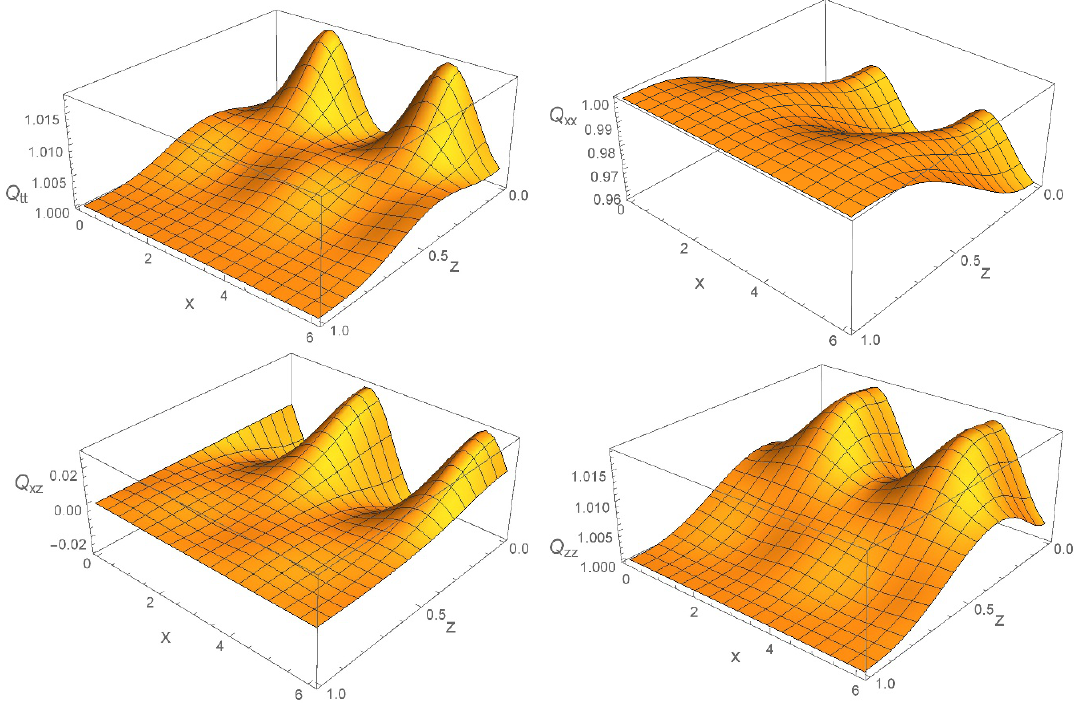
Figure 5 . Bulk solutions for the metric (cid:12)elds Q tt ; Q xx ; Q xz ; Q zz for T = 0 : 01426 and k = 1, for